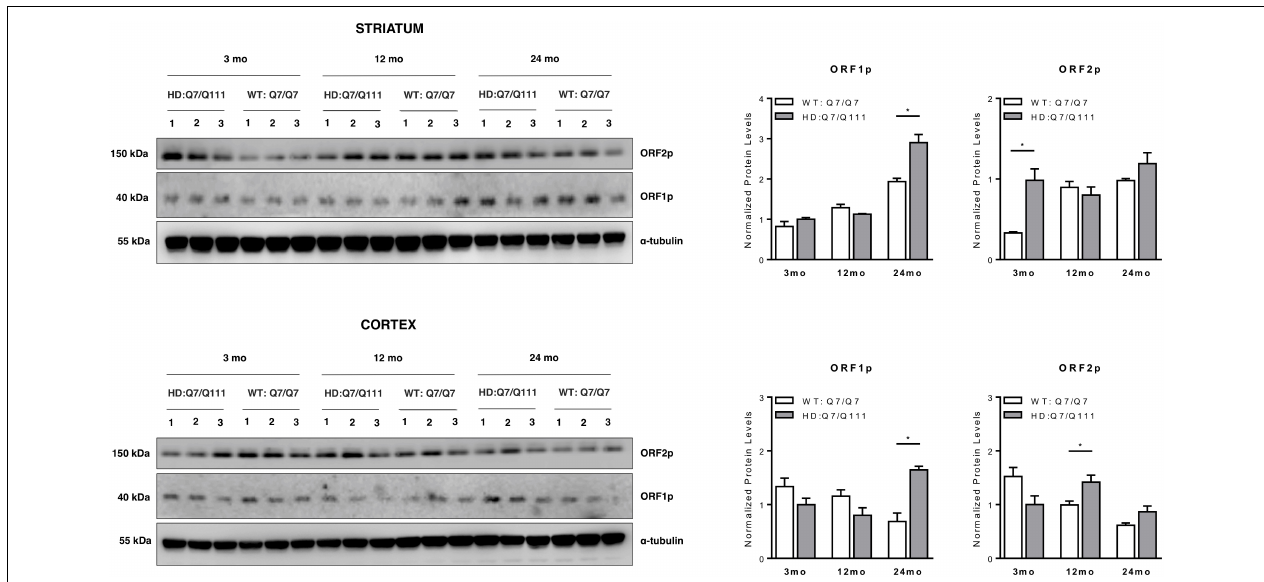
FIGURE 5 | ORF1p and ORF2p expression in postnatal striatum and cortex of HD and WT mice. Representative western blot showing ORF1p and ORF2p levels in protein lysates of striatum (A) and cortex (B) of 3 WT: Q7/Q7 and 3 HD: Q7/Q111 mice at 3, 12 and 24 mo of age. α -tubulin is used as loading control. Bar plots represent normalized protein levels resulting from 3 replica. At each developmental stage, protein levels are compared between WT vs. HD mice. Error bars indicate SEM. * P < 0.05, resulting from paired t